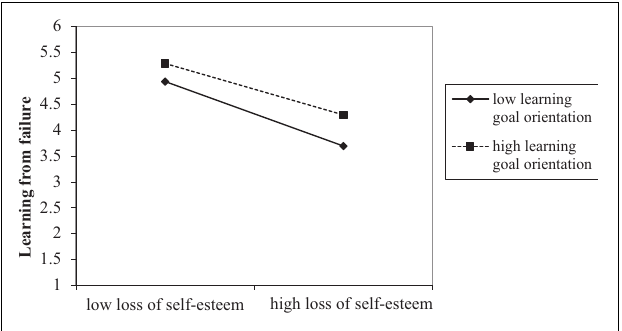
FIGURE 2 | The moderating effect of learning goal